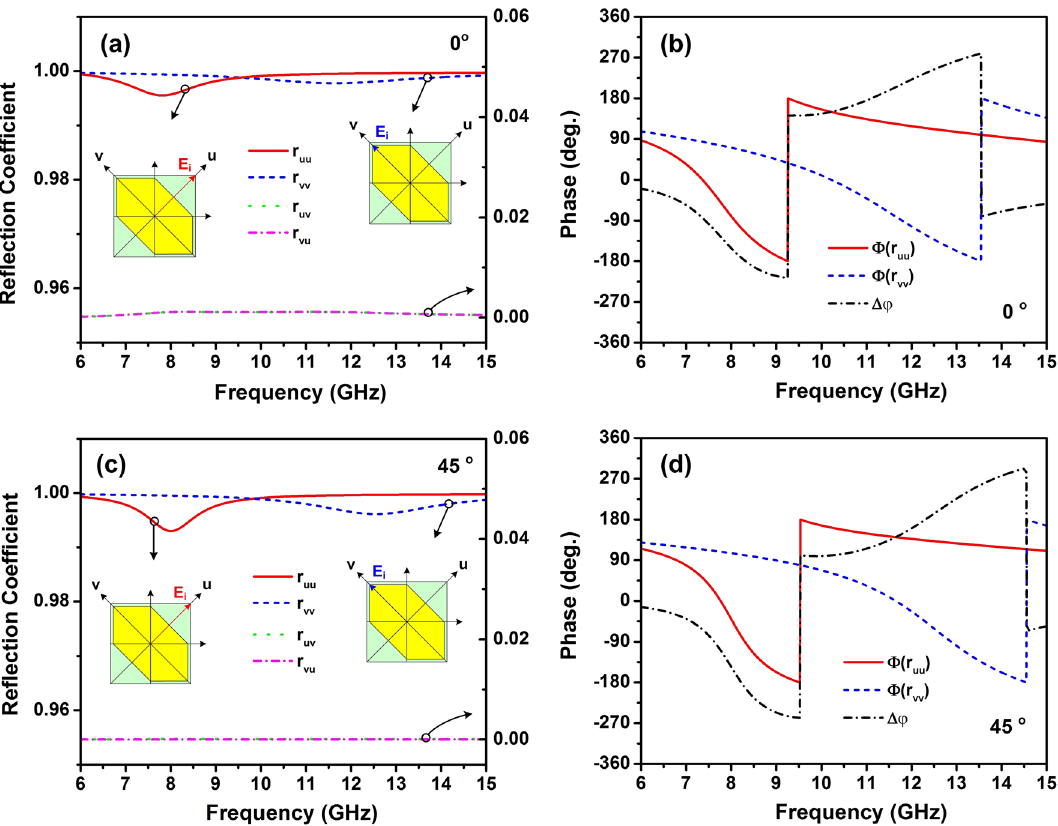
Figure 6. ( a , c ) Magnitude and ( b , d ) phase of the reflection coefficients of u - and v -components for the proposed polarization converter at the normal and 45 ◦ incidence,